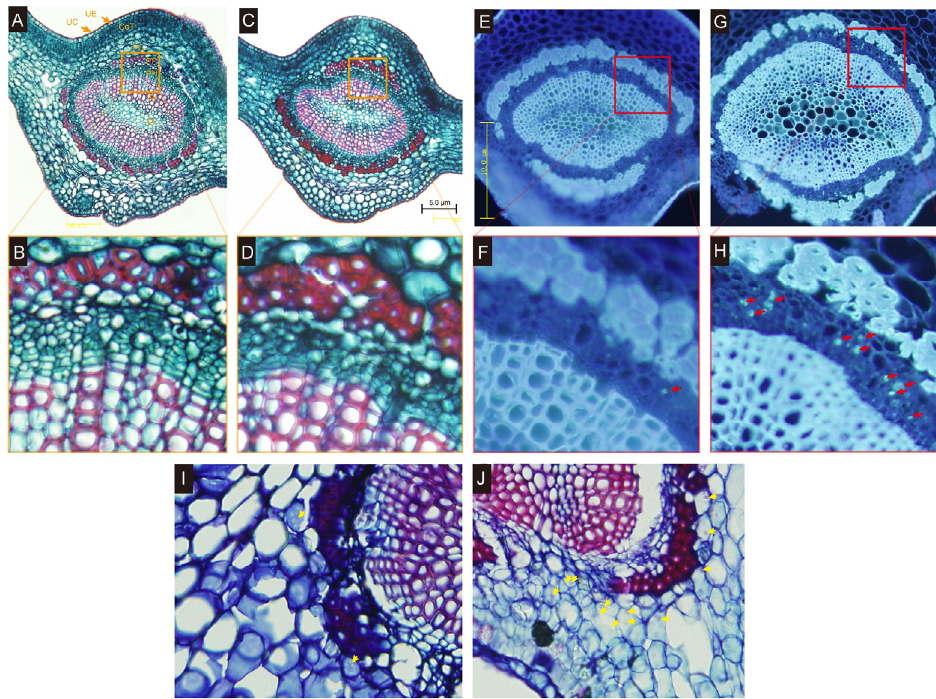
Figure 3. Anatomy modifications of the citrus midribs induced by HLB. Safranin O staining results of the phloem fibers in the control ( A , B ) and HLB plants ( C , D ). ( B ) and ( D ) were magnified graph of the orange rectangle-frame in ( A ) and ( C ), respectively. Aniline blue callose deposition in the phloem of CLas-infected plants ( G , H ) and healthy plants ( E , F ). The fluorescence of the stained callose was marked using red arrows. ( F ) and ( H ) were the magnified red rectangle graph-frame in ( E ) and ( G ), respectively. The accumulation of starch grains stained by methylene blue-azure II-basic fuchsin in the phloem and parenchyma cells of HLB leaves ( J ) and mocked control plants ( I ). The stained starch grains were marked using yellow arrows. UC: upper cuticle; UE: upper epidermis; CoT: collenchyma tissue; PC: parenchyma cell; PF: phloem fiber; Ph: phloem; Xy: xylem; Pi: pith.